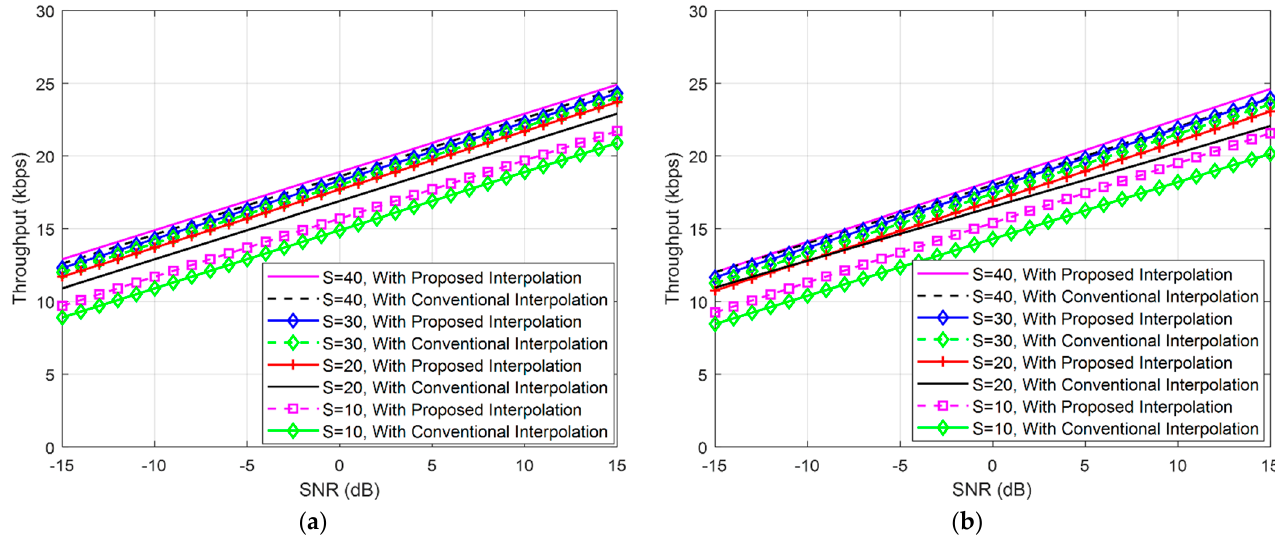
Electronics 2021 , 10 , x FOR PEER REVIEW Figure 13. Throughput performance comparison of the proposed method for conventional and proposed interpolation schemes with LMMSE and its different counterpart channel estimators: ( a ) TU 1 Hz; ( b ) EPA 1 Hz.